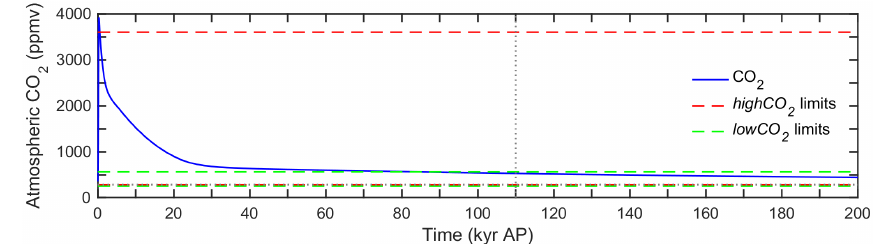
Figure 1. Time series of atmospheric CO 2 concentration (ppmv) for the next 200kyr following logistic CO 2 emissions of 10000PgC, run using the c GENIE model (Lord et al., 2016). Also shown are the upper and lower CO 2 limits of the high CO 2 (red dashed lines) and low CO 2 (green dashed lines) ensembles. The pre-industrial CO 2 concentration of 280ppmv (horizontal grey dotted line) and the 110kyrAP cut-off for the high-CO 2 ensemble (vertical grey dotted line) are included for